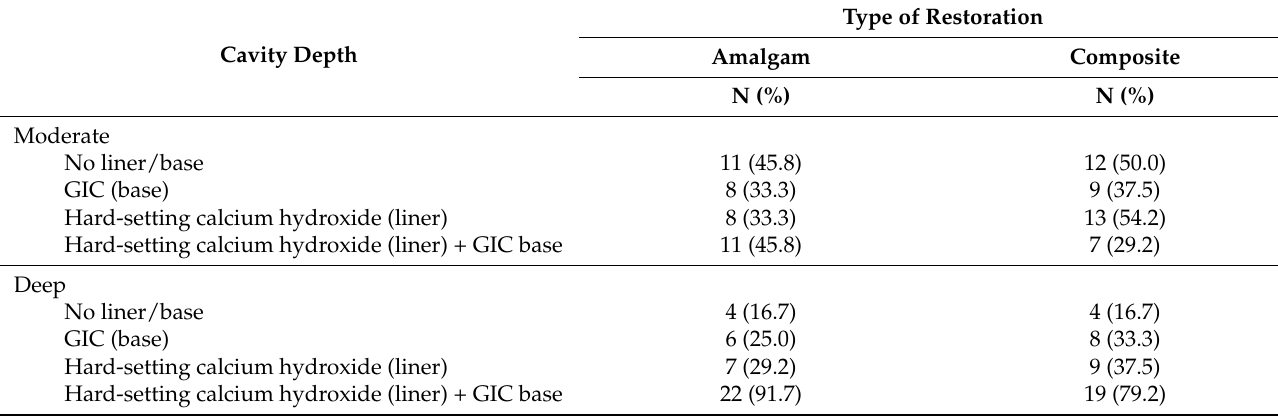
Table 3. The use of liners/base prior to the placement of restoration in Malaysia dental schools ( n = 24).